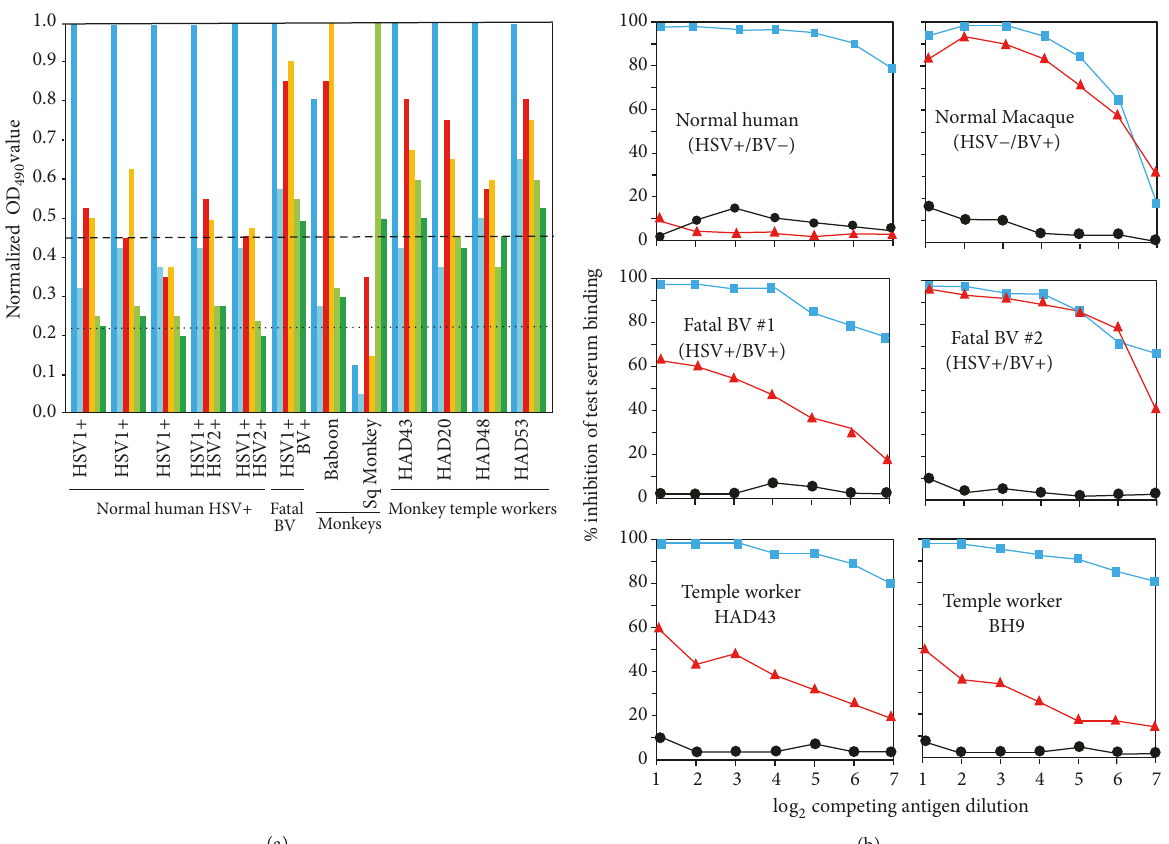
Figure 1: Evidence of possible asymptomatic BV infections in Asia. (a) Sera from individuals working at monkey forests in SE Asia [19, 20] were tested by ELISA as described [21, 22] against HSV1 (dark blue), HSV2 (light blue), BV (red), HVP2 (orange), squirrel monkey herpesvirus (light green), and spider monkey herpesvirus (dark green) antigens. HSV1 OD values were normalized to 1.0 to assess relative levels of reactivity with cross-reactive antigens. Average levels of cross-reactivity with BV and HVP2 in normal HSV-positive control sera (individuals with no known contact with monkeys) are indicated by the dashed line, and average levels of cross-reactivity with the two S. American monkey viruses are indicated by the dotted line. The four sera from monkey forest workers and serum from a fatal case of zoonotic BV infection have higher levels of cross-reactivity with all simian virus antigens than do control sera. (b) Competition ELISAs were performed as described [23, 24] to determine if sera from monkey forest workers with high levels of cross-reactivity were consistent with having been infected with BV. Soluble antigens (extracts of cells infected with HSV1 (blue), BV (red), or uninfected cells (black)) were used to compete the binding of serum to HSV1 antigen coated onto the ELISA plates. Binding of control HSV1-positive serum was inhibited only by soluble HSV1 antigen, not by BV or control antigens. Binding of BV-positive macaque serum (HSV-negative) to the solid phase HSV1 antigen was equally competed by soluble HSV1 and BV antigens. Binding of sera from two patients that died of zoonotic BV infection (both HSV1-positive) were competed by both HSV1 and BV soluble antigens, although competition by BV antigen was less than by HSV1 antigen. Binding competition for sera from two monkey forest workers (both HSV1-positive) was similar to that of zoonotic BV patient sera.